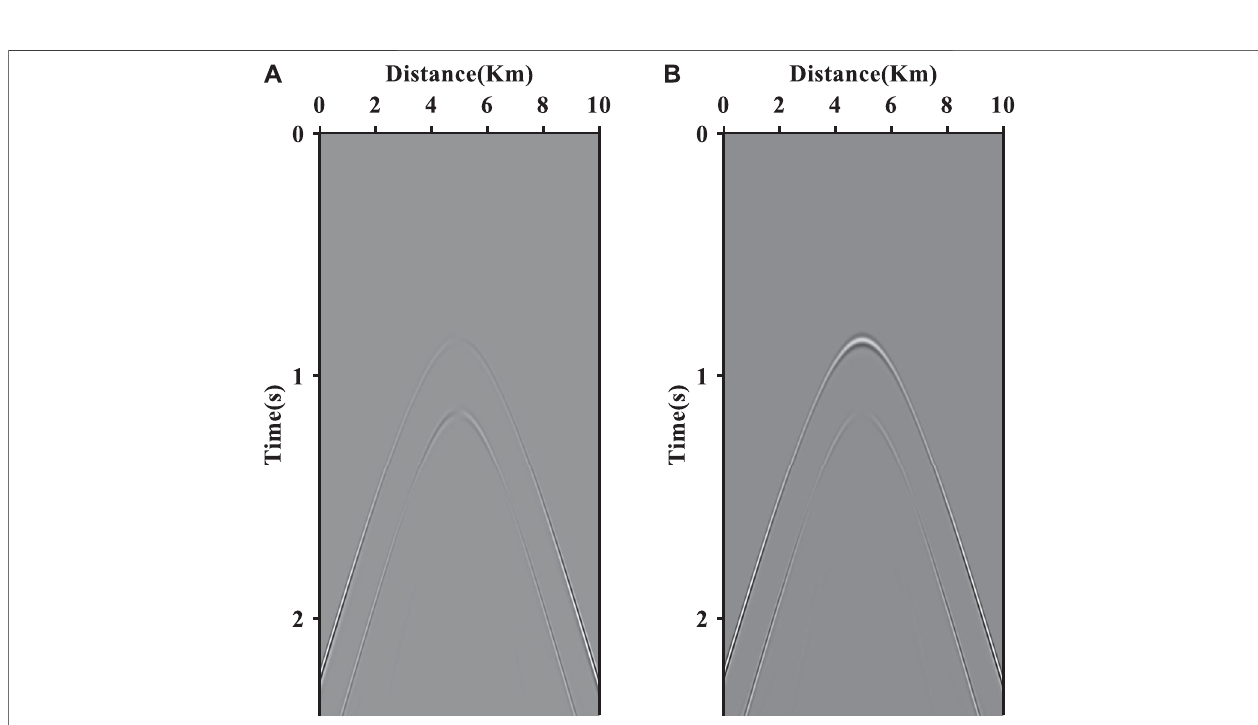
FIGURE 8 | The synthetic multicomponent seismic record without direct wave: (A) x-component and (B) z-component.